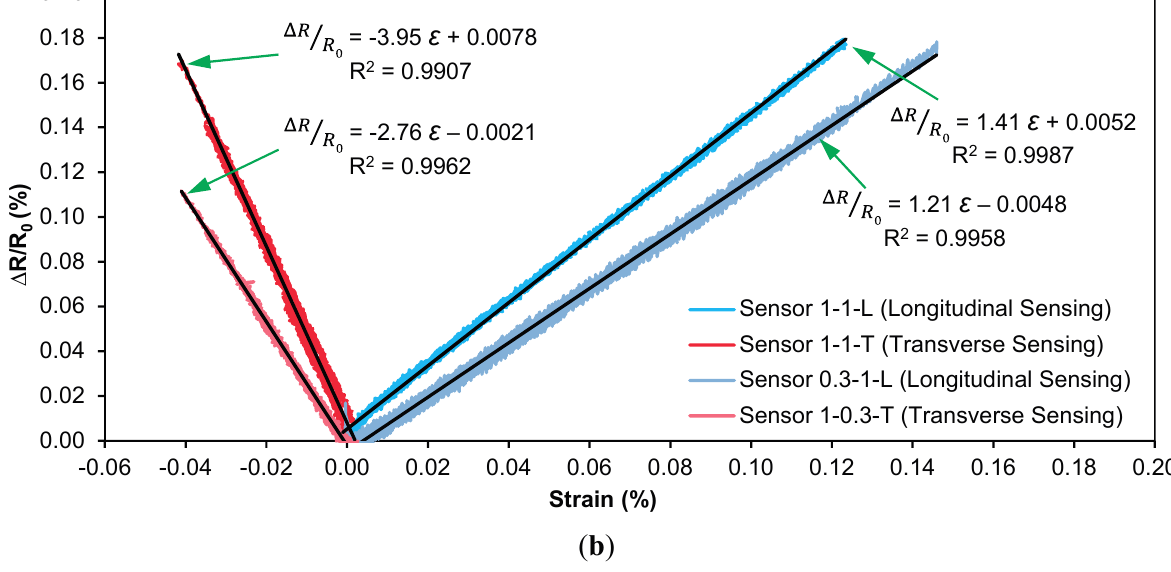
Figure 10. ( a ) Applied load and longitudinal and transverse strain of the steel specimen and ( b ) the sensing response of the four sensors, showing the linearity and gage factors estimated using linear least squares curve